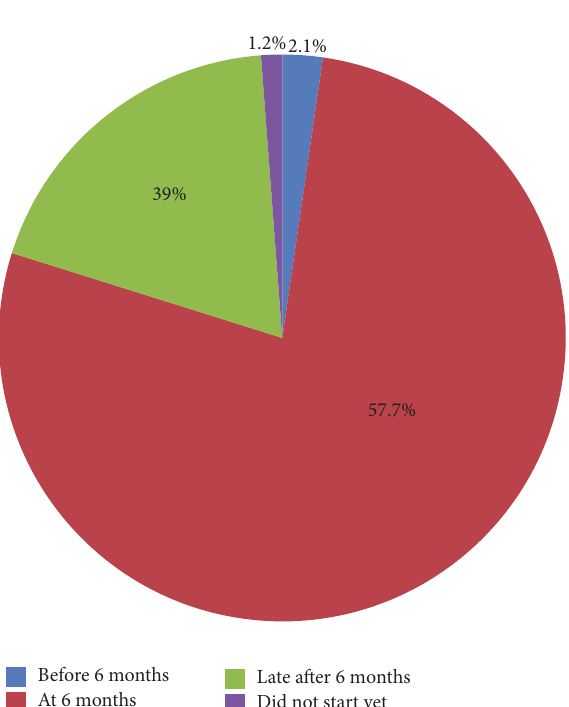
Figure 1: Time of starting complementary feeding for their children by study participants, Lasta District, Amhara region, Ethiopia, 2015.